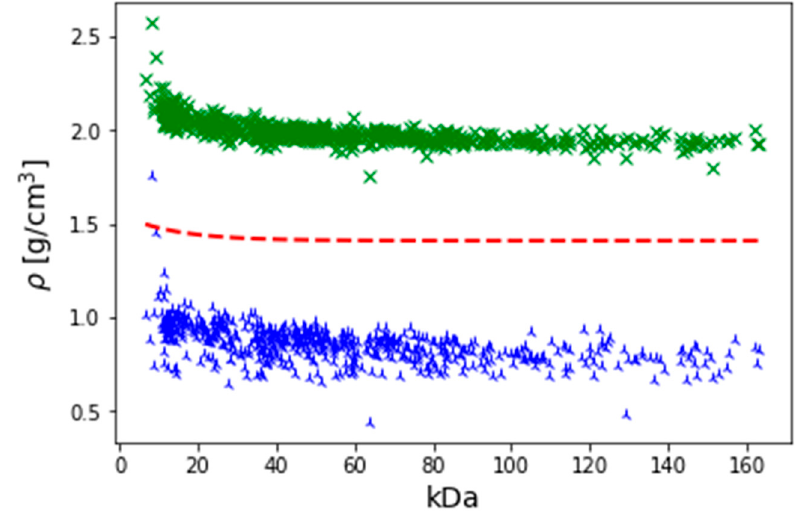
Figure A2. A plot of density versus mass for a range of proteins of various sizes. Blue: van der Waals radius. Green: Etch radius. Red: Experimentally desired result from Equation (A7).